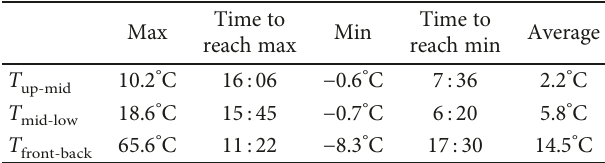
Table 4: Summarized result of temperature di ff erence between the upper, middle, and lower heat-absorbing aluminum plate and back of the insulation